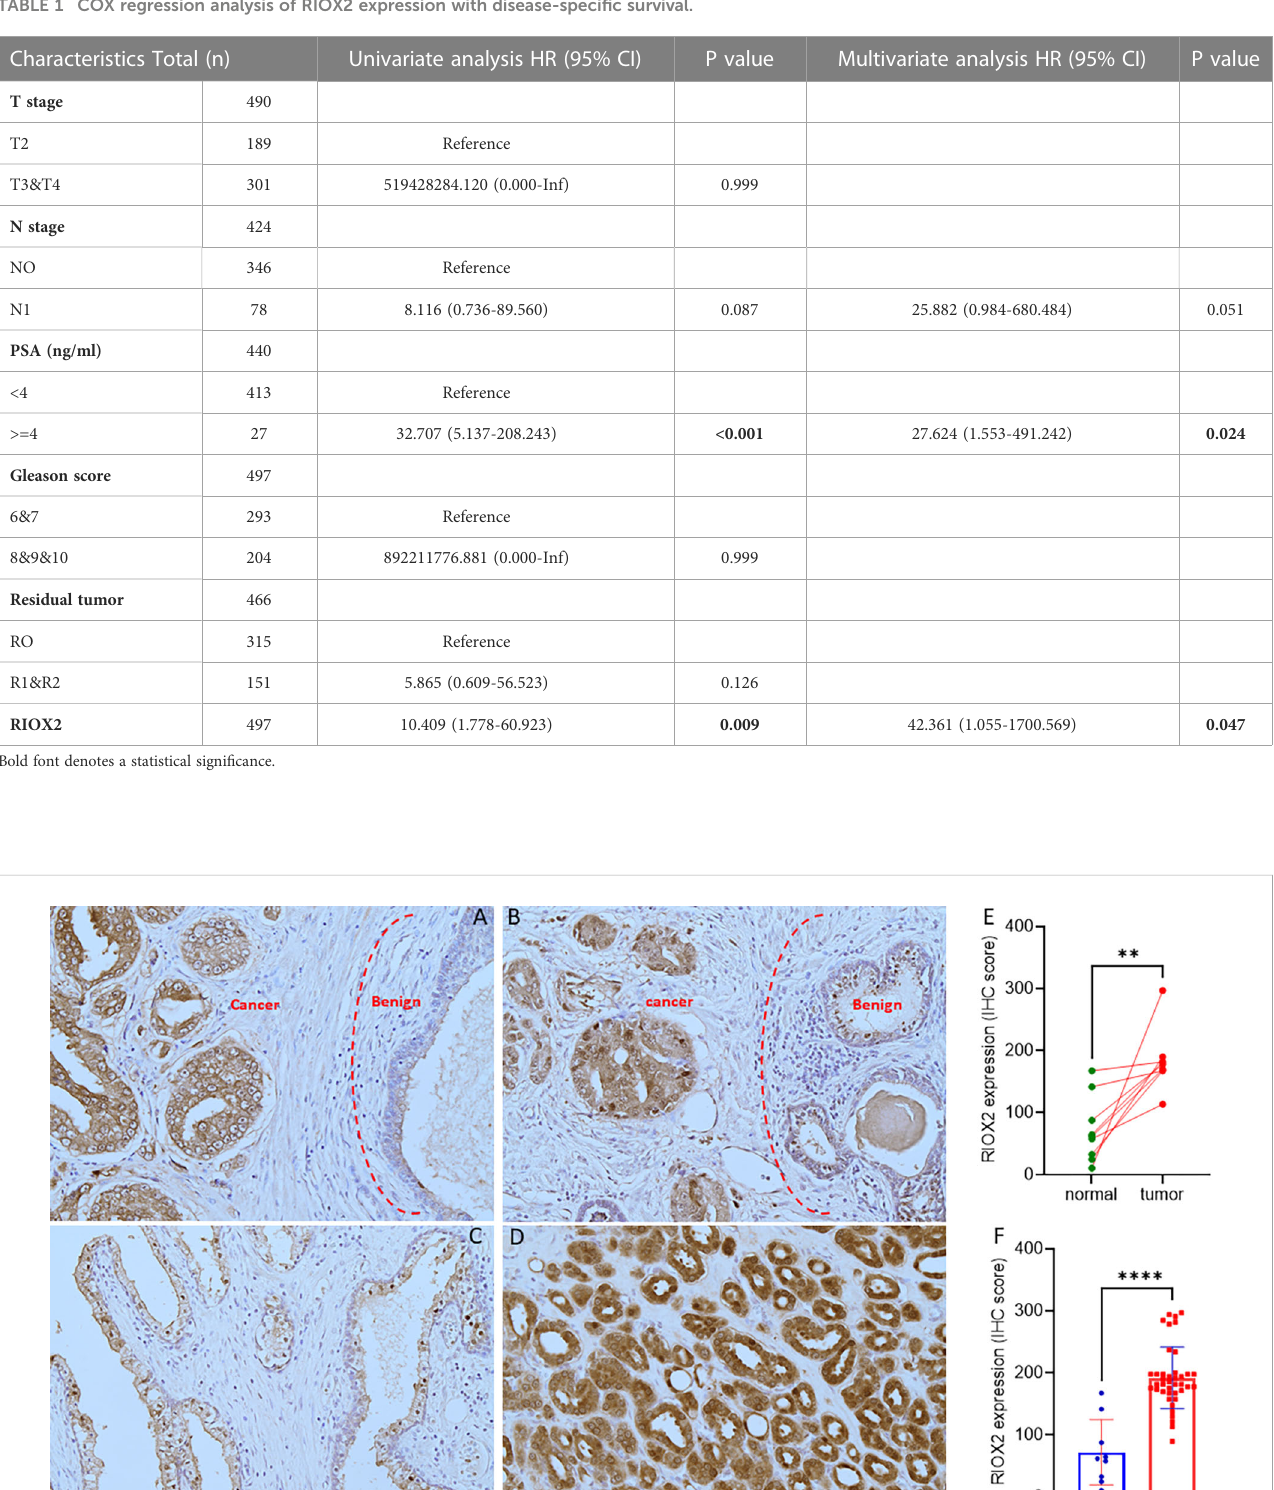
TABLE 1 COX regression analysis of RIOX2 expression with disease-speci fi c